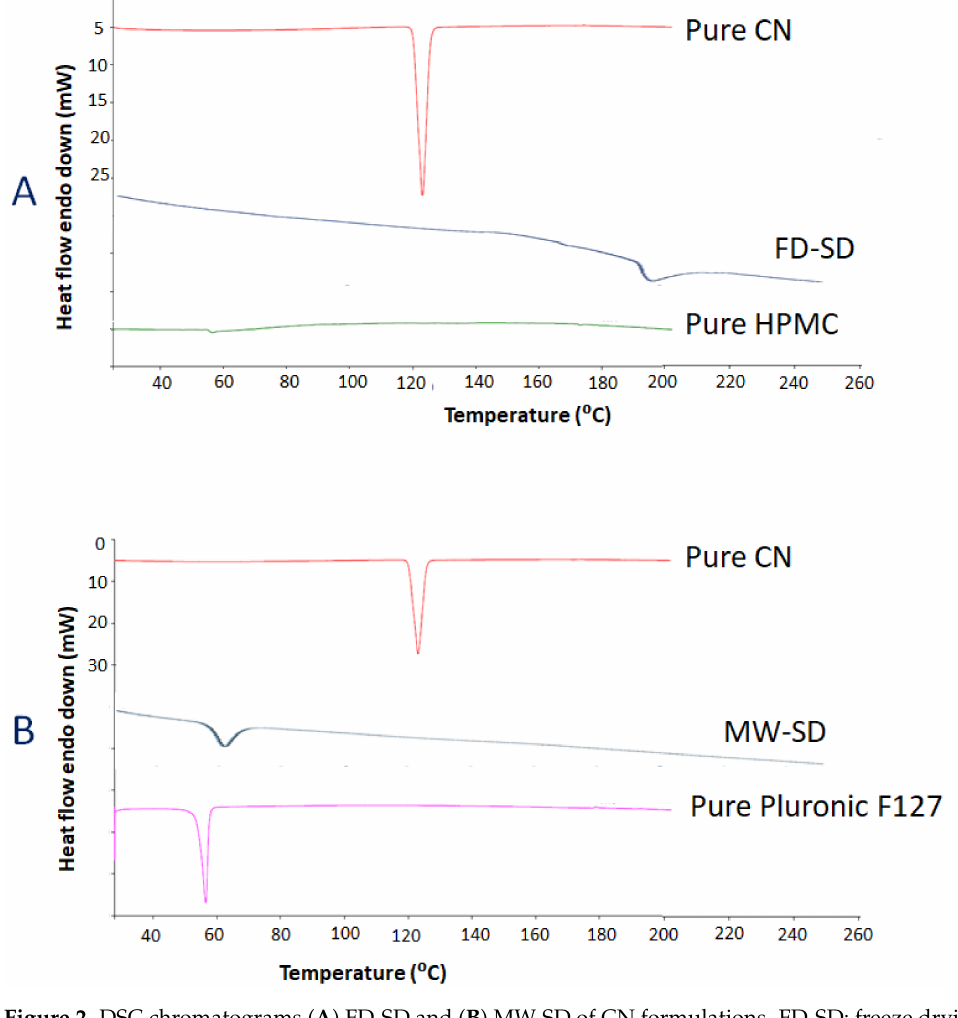
Figure 2. DSC chromatograms ( A ) FD-SD and ( B ) MW-SD of CN formulations. FD-SD: freeze drying induced solid dispersion, MW-SD: microwave induced solid dispersion, CN: